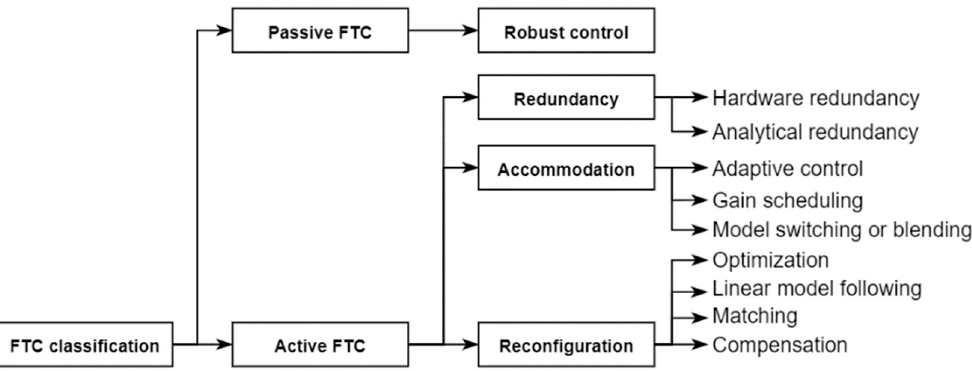
Figure 6. Classification of fault-tolerant control strategies.